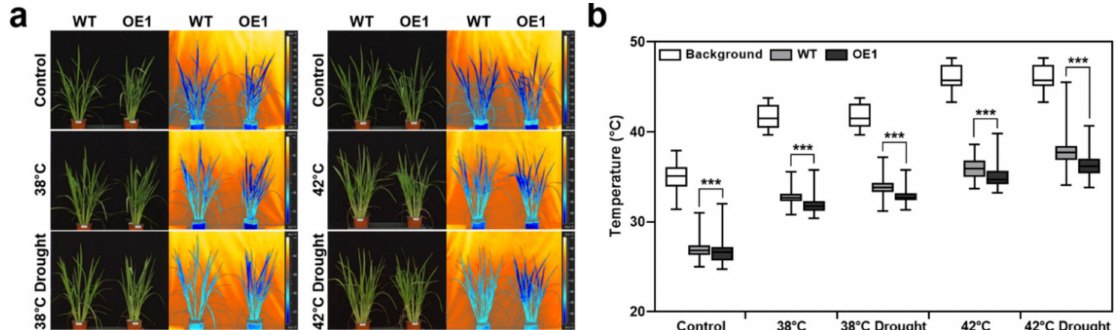
Figure 5. Phenotyping leaf temperature of OsERF115/AP2EREBP110 -OE transgenic and WT rice plants under heat or heat-drought combined stress. ( a ) Visible and thermal images taken by FLIR P620 camera. Plants at the V6 stage exposed to heat (38 ◦ C or 42 ◦ C) or heat-drought combined stress for 3 days in an environmental controlled Phytotron. All thermal images were taken at the same time when the ambient temperature approached to maximum of the day. ( b ) Average leaf temperature values under heat or heat-drought combined stress. Thermal images were analyzed with FLIR 1.2 SP2 software. Data represent mean ( ± SD) from 20 pixels from 2~3 leaves of 3 plants of each line with two independent experiments. Two-way ANOVA and Fisher’s LSD test were performed by comparing with WT plants as controls (***, p <